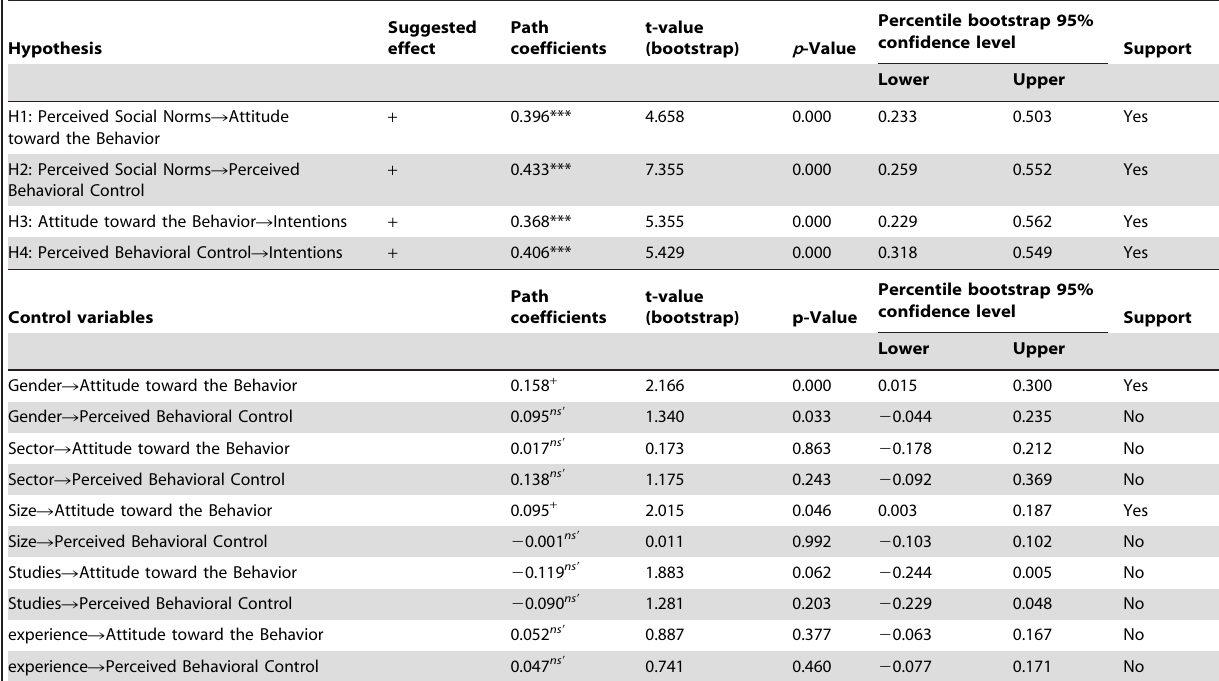
Table 6. Structural model